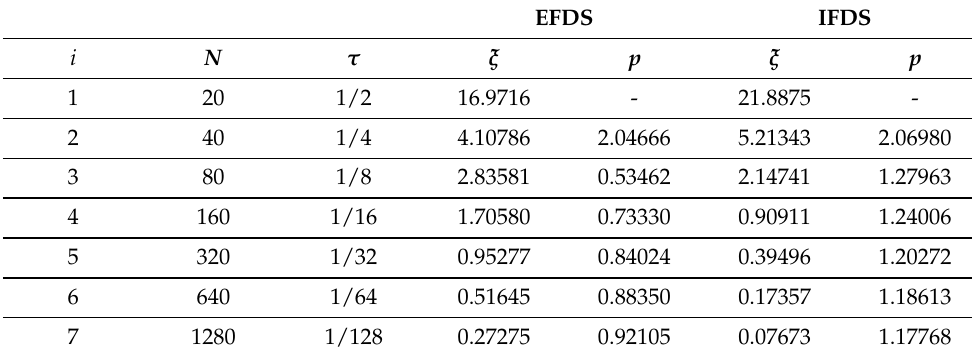
Table 3. Computational accuracy EFDS and IFDS, at T =